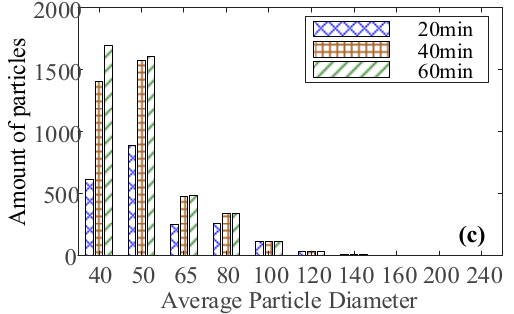
Figure 13. The ferrous particle size distributions at ( a ) normal, ( b ) unbalance, and ( c ) abrasive wear.